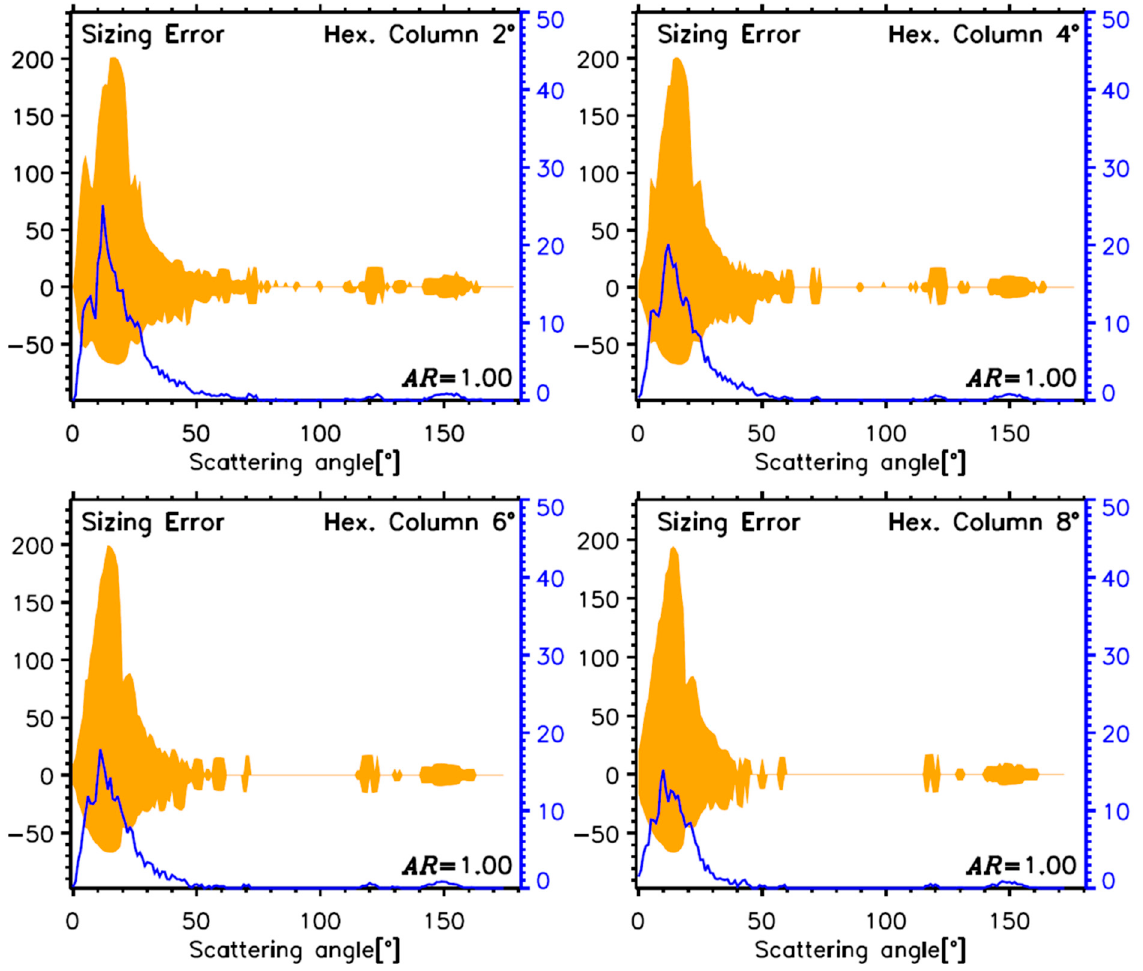
Figure 18. Determined ranges (orange shaded areas, left vertical axis) of minima and maxima and average (blue lines, right vertical axis) of sizing errors (%) for measured hexagonal ice crystals with AR = 1.00 only using the ADDA as a function of scattering angle. Different panels indicate different resolutions (i.e., 2°, 4°, 6°, and 8°) of scattering angles.